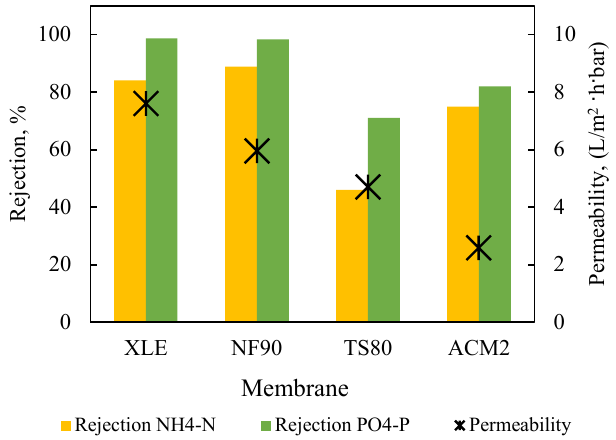
Figure 3. Performance of XLE, NF90, TS80, and ACM2 membranes regarding permeability and nutrient rejection; constant pressure 5 bar. Feed: synthetic solutions.